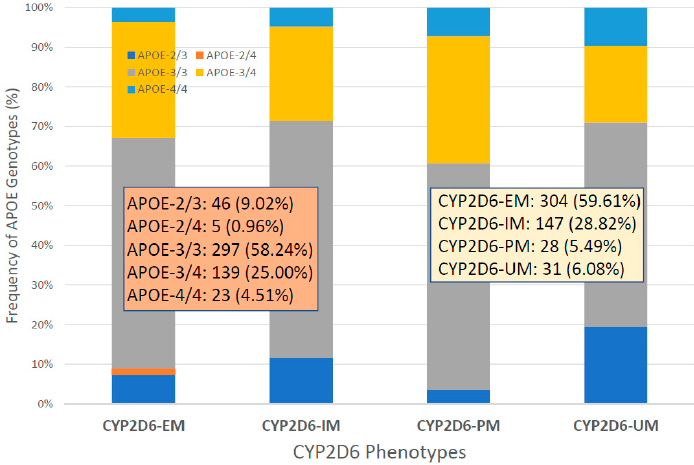
Figure 18. Distribution and frequency of APOE genotypes associated with the phenotypic condition of CYP2D6 extensive (EM), intermediate (IM), poor (PM) and ultra-rapid metabolizer (UM).